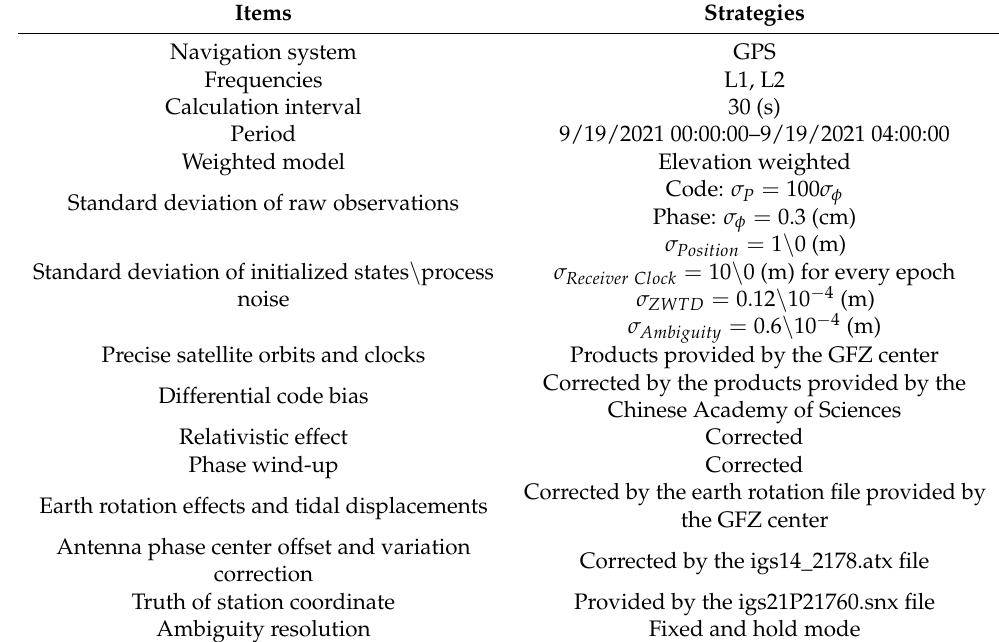
Table 2. Detailed processing strategies for the experimental static